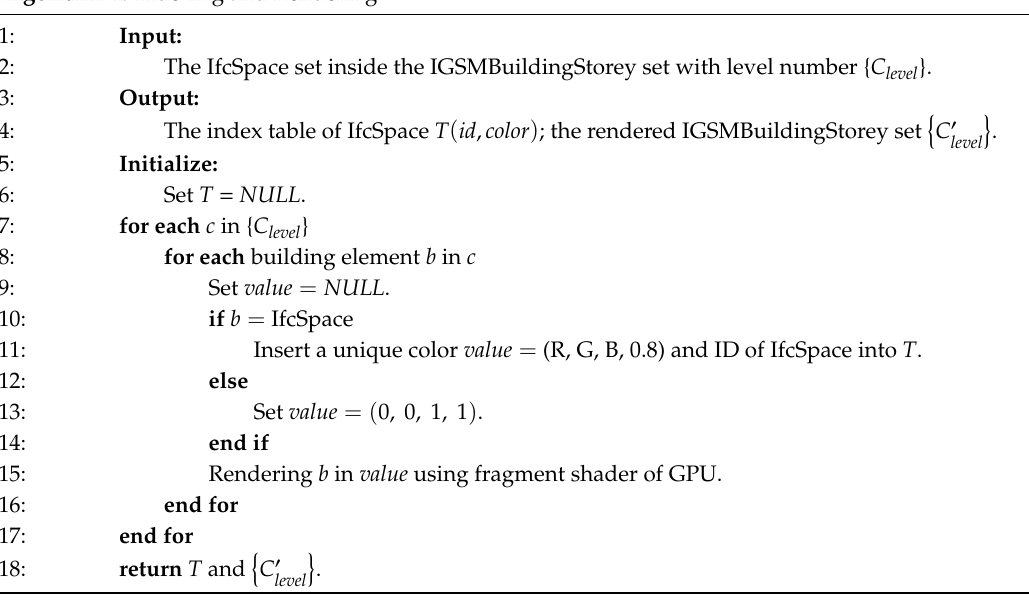
Algorithm 4. Indexing and